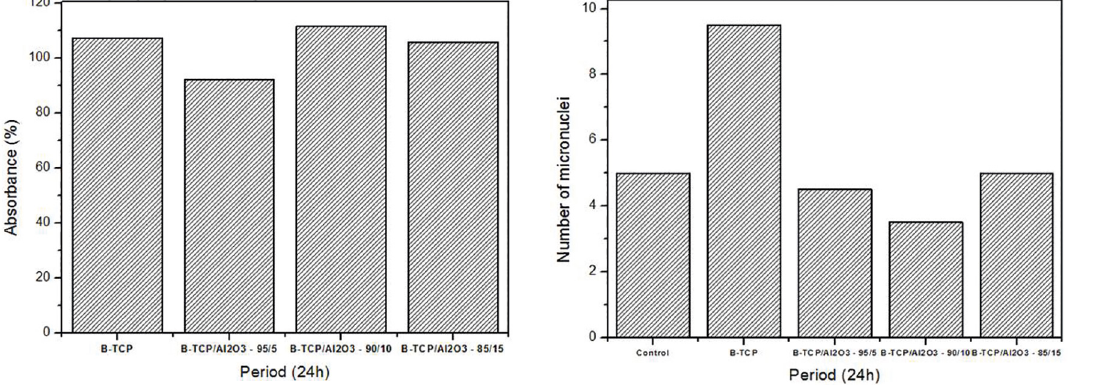
Figure 9. Graph showing number of micronuclei in 1,000 cells/well O after contact of the cells with β-TCP/Al 2 3